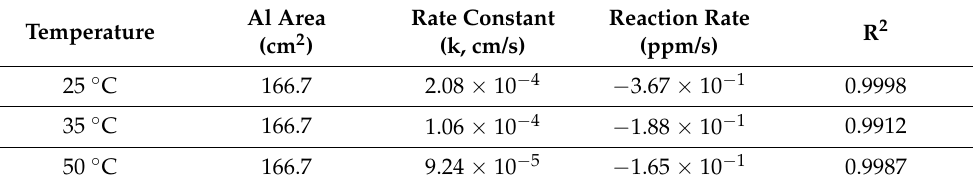
Table 5. Summary of rate constant for the cementation of Au as a function of temperature (base conditions: 10 mL solution containing 1 M of Na 2 S 2 O 3 , 0.5 M of NH 3 , 0.25 M of (NH 4 ) 2 SO 4